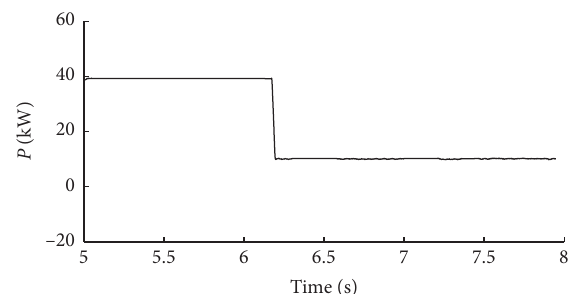
Figure 11: Output power of the ESS (output power falls from 40kW to 10 kW).